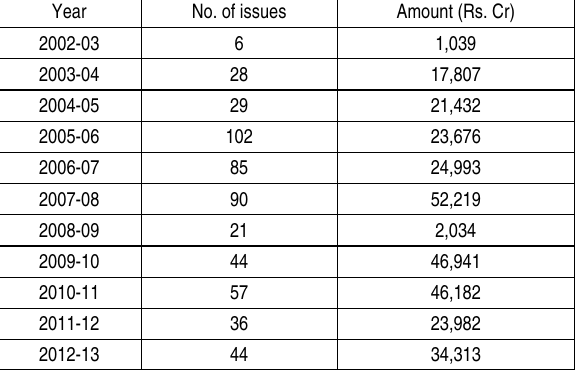
Table 1. Number of IPOs and amount raised by Indian companies from 2002 to